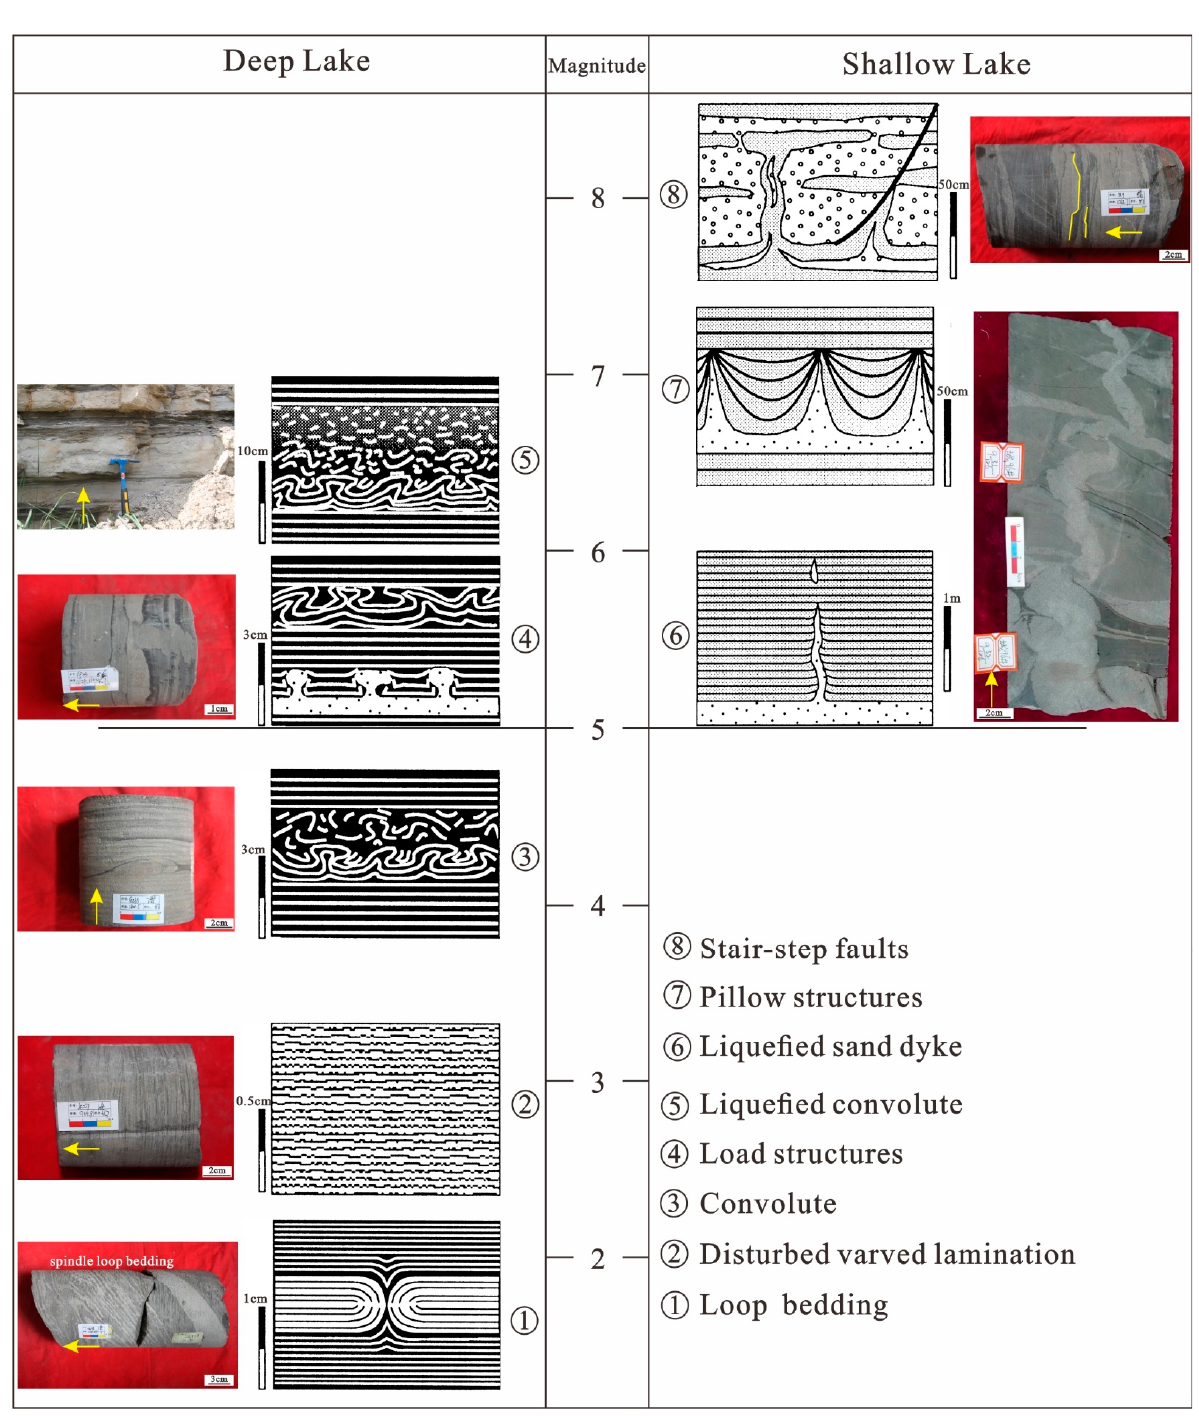
Figure 5. Relationship between the main types of seismites and seismic intensity in the Chang-7 Member.